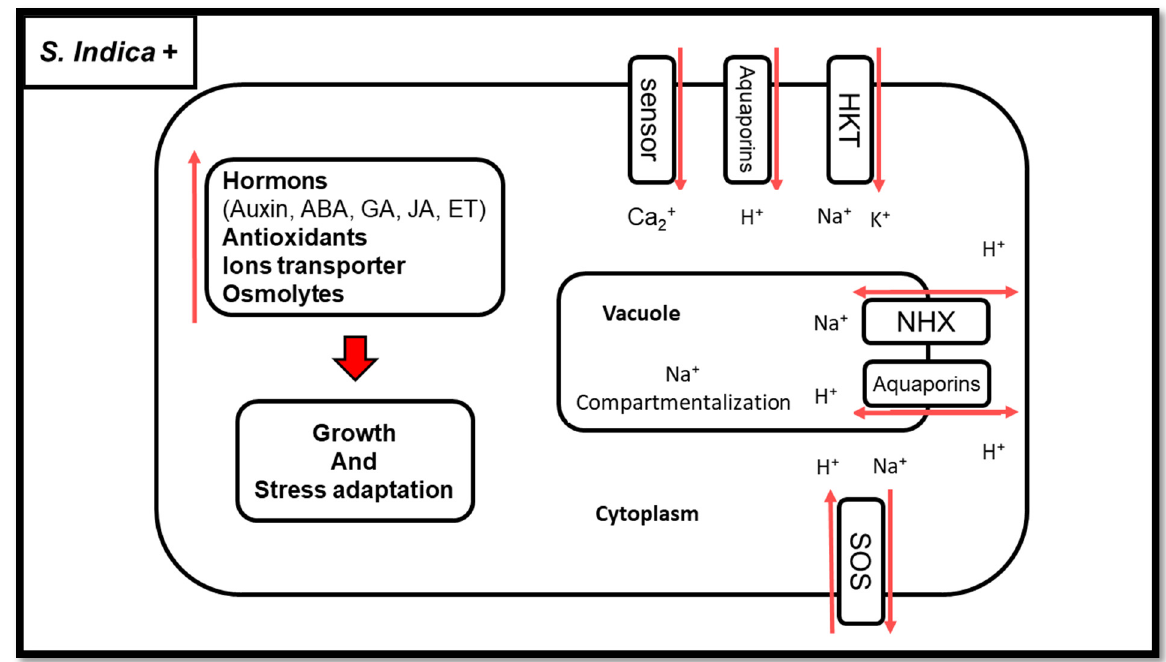
Figure 3. A schematic representation of root cells colonized by S. indica under salinity conditions. Nomenclature is as proposed by Gazara et al. [142]. HKT—high K ⁺ transporters; SOS—salt overly sensitive; NHX—sodium/hydrogen antiporter; Na ⁺ —sodium; H ⁺ —hydrogen; K ⁺ —potassium; ABA—abscisic acid; GA—gibberellin; JA—jasmonic acid; ET—ethylene.